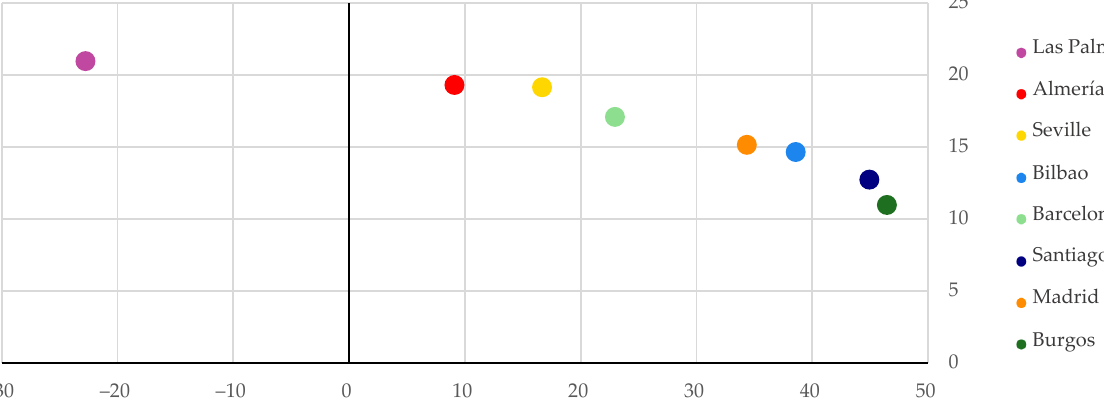
Figure 8. Total energy savings (%) of model B in relation to the reference model regarding the average annual temperature (°C) in each of the 8 cities.